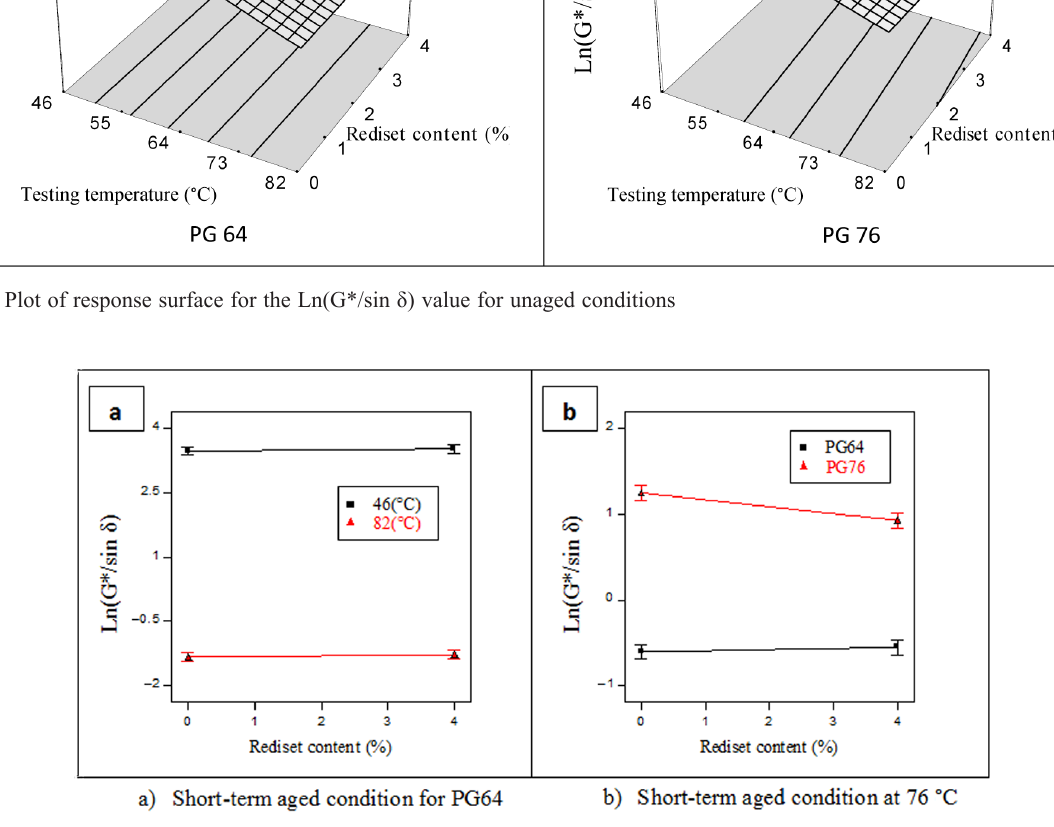
Fig. 7. Interaction effects of Rediset with temperature and binder type on the value of Ln(G*/sinδ) for selected